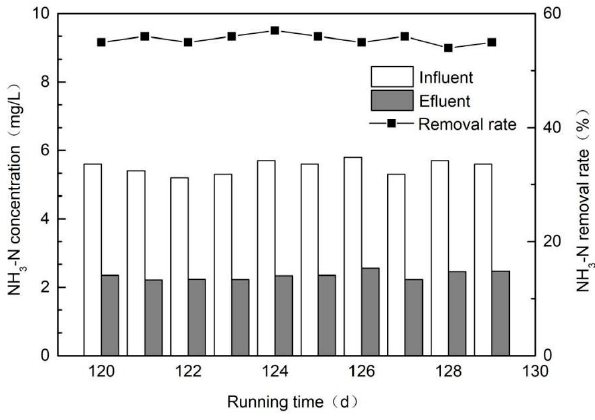
Figure 7. Chart of NH 3 -N removal when the influent NH 3 -N exceeded the standard.